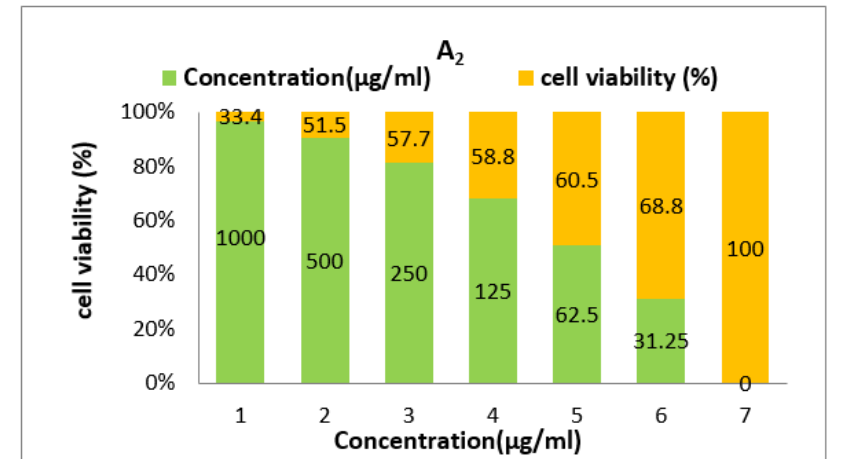
Fig. 12. The relationship of the percentage of inhibition with the concentration of (A 2 )